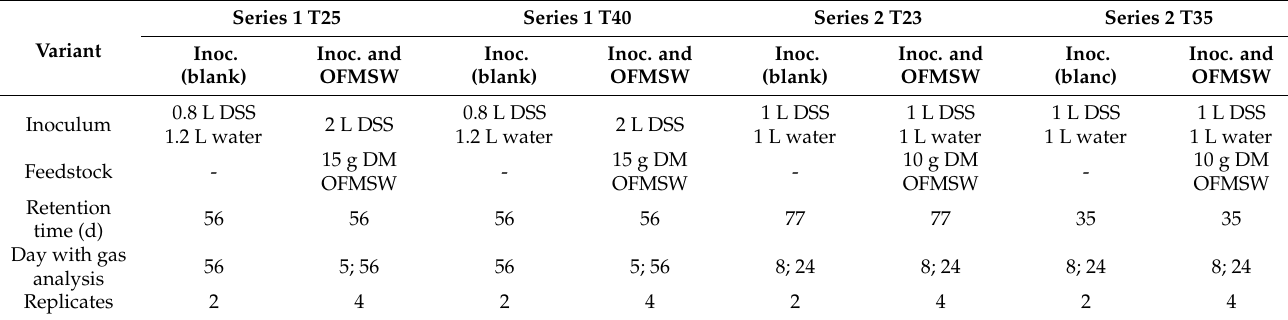
Table 2. Experimental setup of the anaerobic digestion experiments of both test series at 25/40 ◦ C and 23/35 ◦ C. Digested sewage sludge (DSS) was used as inoculum (Inoc.), while dry matter (DM) of the organic fraction of municipal solid waste (OFMSW) served as